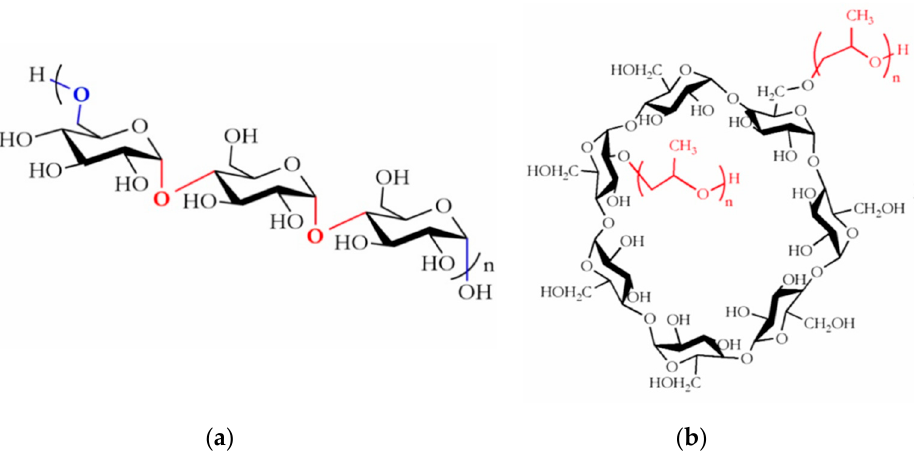
Figure 1. ( a ) Repeating unit of pullulan; ( b ) chemical structure of Hydroxypropyl- β -cyclodextrin (HP- β -CD).